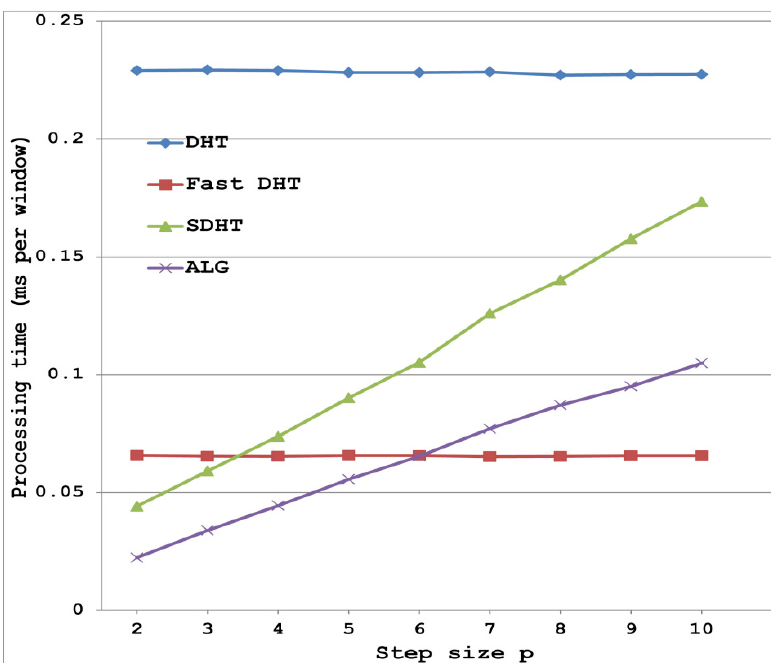
Figure 1. Performance of the tested algorithms in terms of runtime (milliseconds) per window when N = 256 and p varies from 2 to 10.